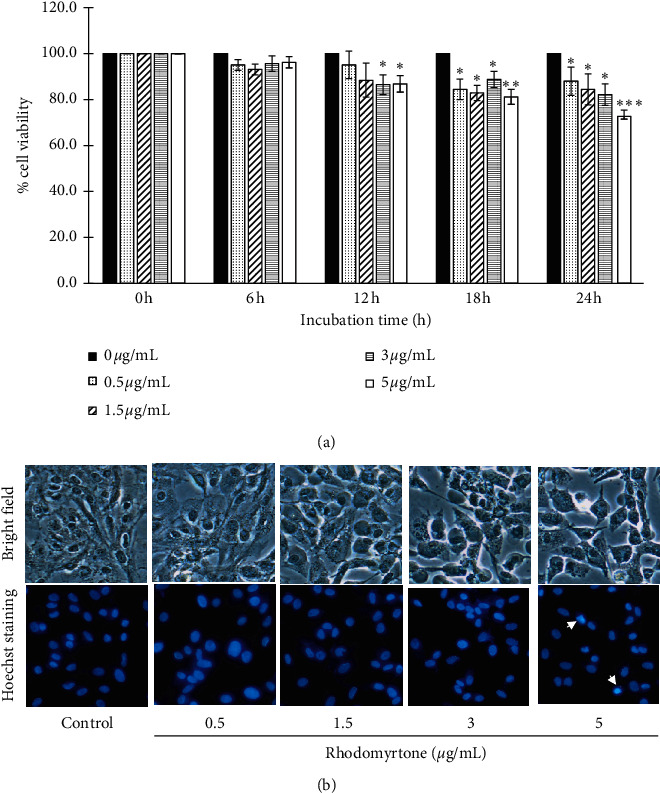
Effect of SW1353 cell viability by rhodomyrtone. (a) Cell viability was analyzed by MTT assay for 24 h. Rhodomyrtone inhibited SW1353 cell growth in a time- and concentration-dependent manner. (b) Nuclear morphology changes were detected by Hoeschst 33342 staining. Rhodomyrtone at 0–3 μg/mL (cell viability >80%) was selected for subsequent experiments. The arrows indicate apoptotic cells. Data were expressed as mean ± standard deviation (SD) from three independent experiments.